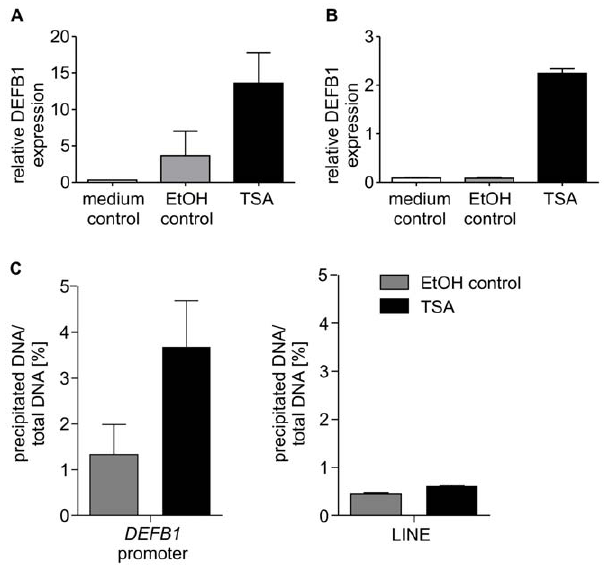
Figure 1. Modulation of DEFB1 gene expression and histone H3 acetylation by the HDAC inhibitor TSA. The human lung epithelial cell lines A549 (A) and NCI-H727 (B–C) were treated with the HDAC inhibitor trichostatin A for 24 h. (A–B) mRNA expression of DEFB1 was analyzed using quantitative Real-Time-PCR. The measured levels of mRNA were normalized to PBG-D mRNA levels. (C) ChIP analysis was performed using anti-acetyl-Histone H3 antibody. Isolated DNA was quantified using quantitative RT-PCR. Bars represent means with SD of three independent experiments. LINE: long interspersed nuclear